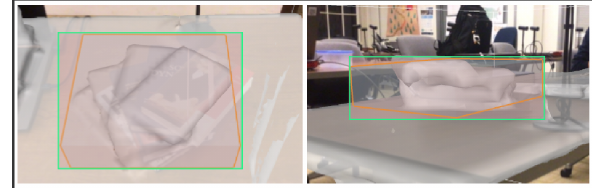
Figure 9: Screenshots of our app generating 2D bounding boxes around a stack of books. The orange wireframe is the outline of the 3D bounding box, and the shaded green rectangle is the 2D one. The computer mesh is shown in white, superimposed on top of the real world